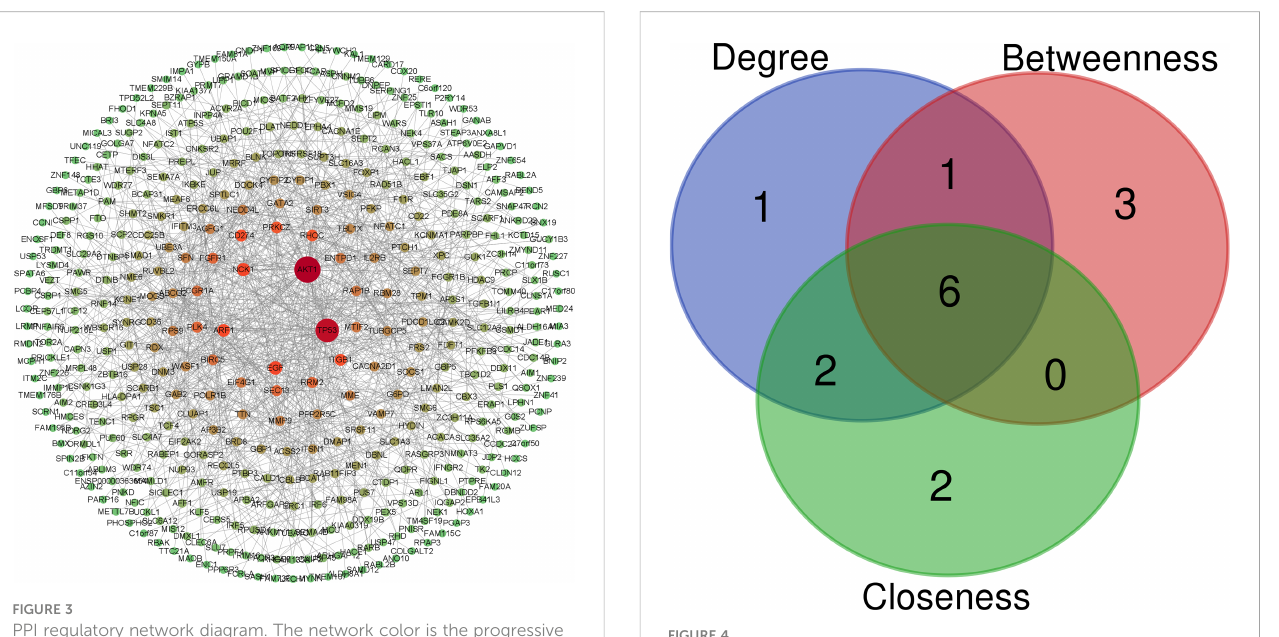
FIGURE 4 Wayne diagram of intersection of top ten key nodes by DC, BC and